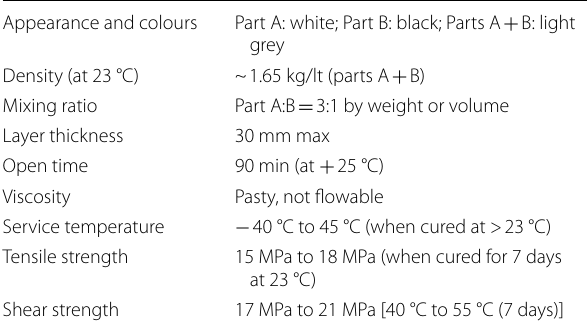
Table 3 Sikadur ® -30 LP (two-part epoxy impregnation resin).